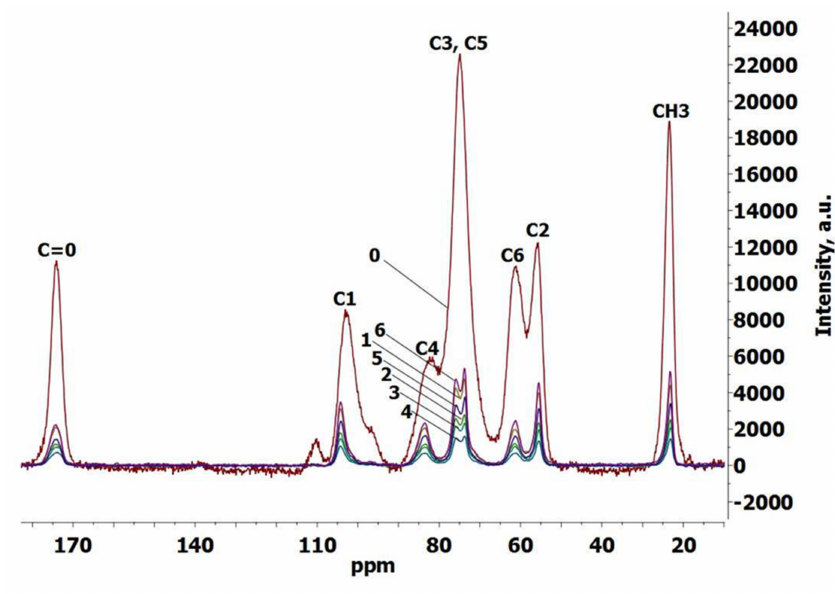
Figure 1. 13 C CP-MAS NMR spectra of chitin and chitin cryogels: 0 = chitin, 1–6 = chitin cryogel samples according to Table